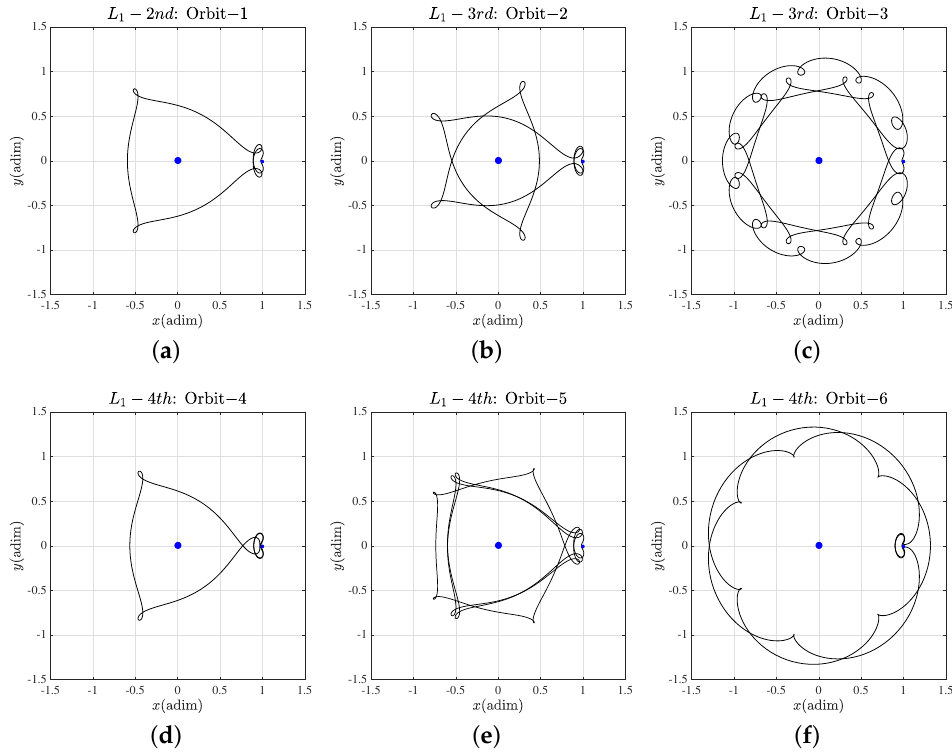
Figure 15. Example RTPOs passing through the L 1 region in the Sun–Jupiter system. ( a ) Orbit-1: initials generated by the second intersection of the trajectory with the x -axis (see Figure 13b). ( b ) Orbit- 2 and ( c ) Orbit-3: initials generated by the third intersection of the trajectory with the x -axis (see Figure 13c). ( d ) Orbit-4, ( e ) Orbit-5 and ( f ) Orbit-6: initials generated by the fourth intersection of the trajectory with the x -axis (see Figure 13d). The larger and the smaller blue dots represent the positions of P 1 and P 2 , respectively.